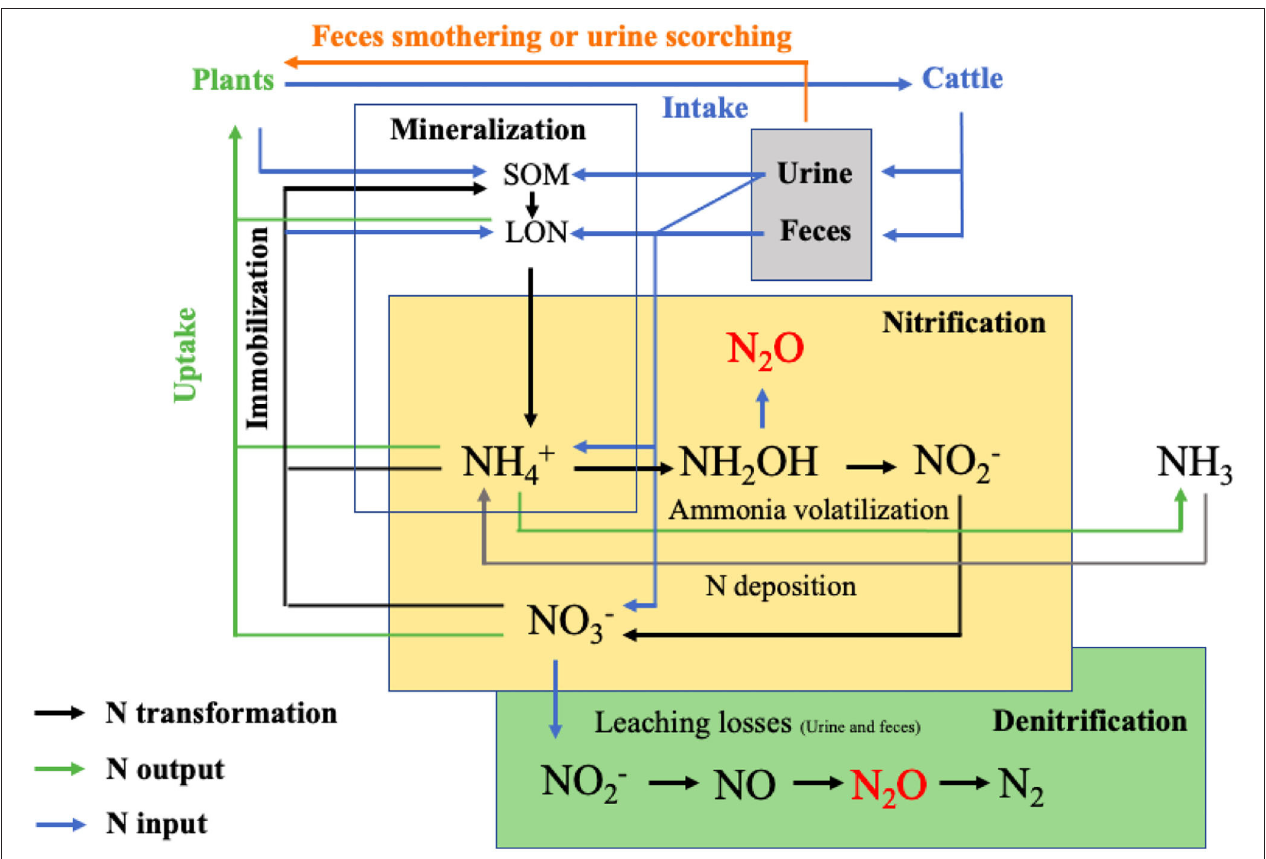
FIGURE 1 | Pathways of microbial driven nitrogen transformations in excreta patches in grassland ecosystems (Cai et al., 2017). The N 2 O can also be produced by nitrifier denitrification, chemodenitrification and dissimilatory nitrate reduction to ammonium. The SOM and LON are soil organic matter and labile organic nitrogen,